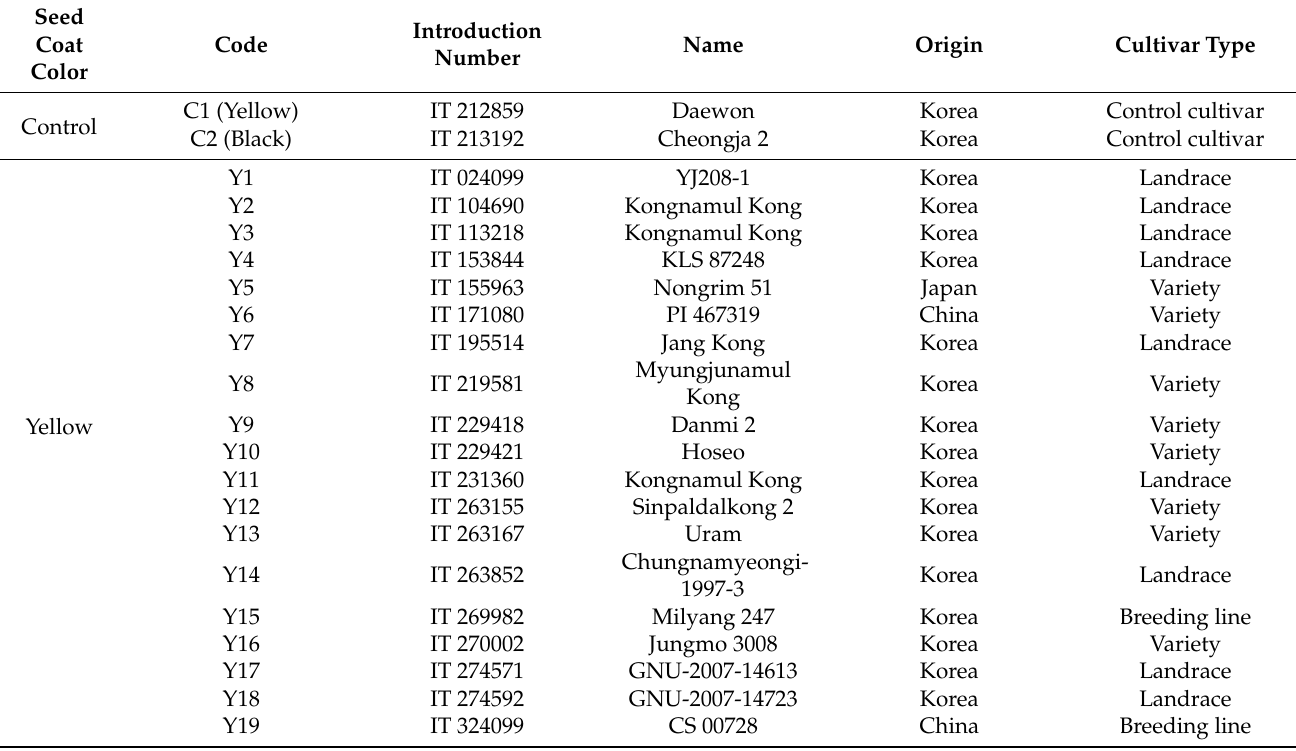
Table 1. Classification by different seed coat colors and information on soybean seeds (Reprinted with permission from Ref. [10]. 2021, Chu et